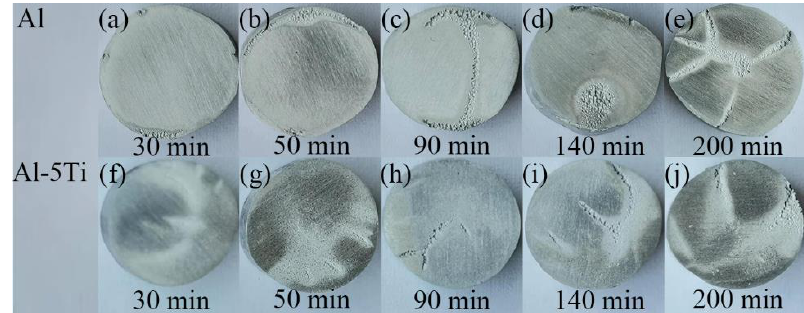
Figure 3. The macroscopic morphology of Al and Al-5Ti alloys after different cavitation erosion time ( a – e ) Al, ( f – j ) Al-5Ti.